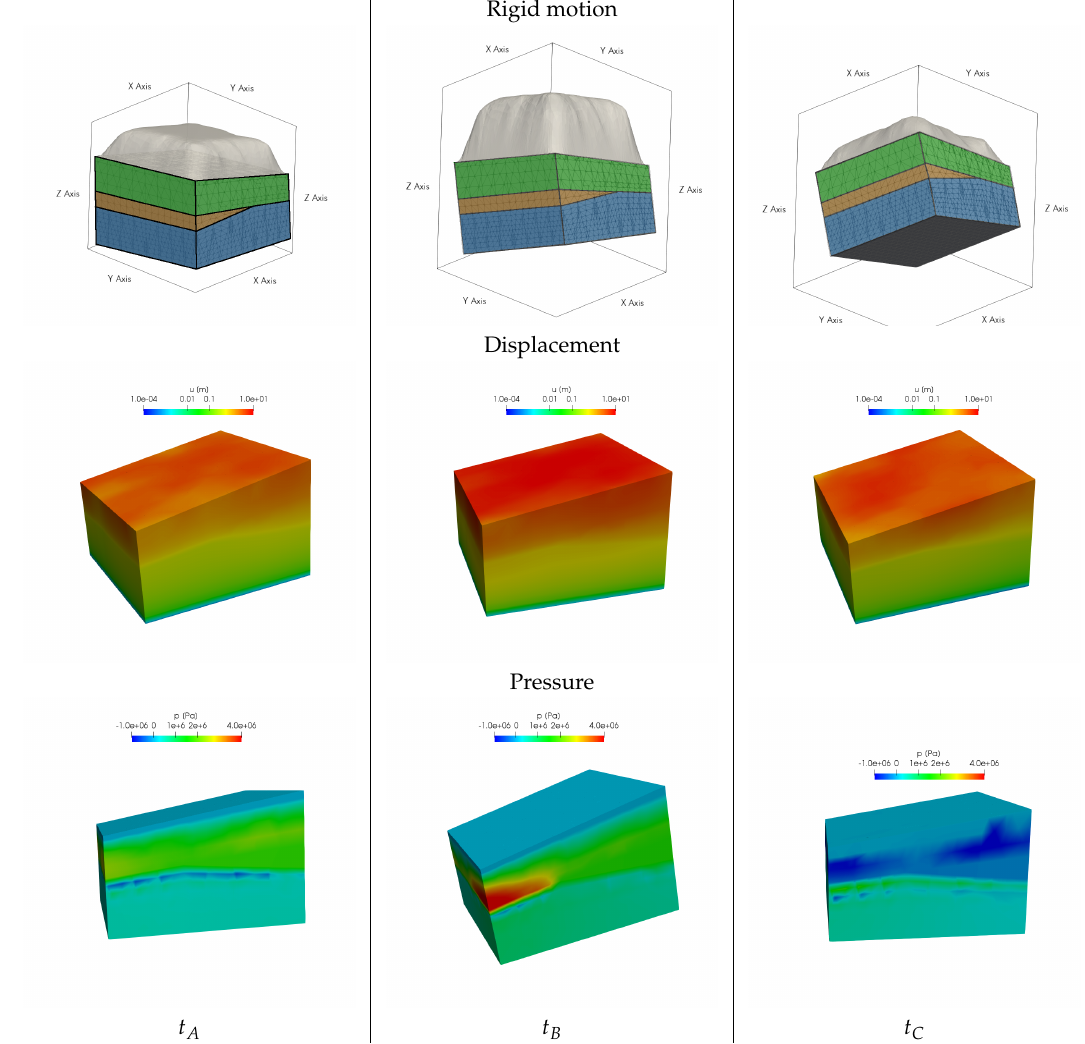
Figure 12. Evolution of the isostatic adjustment, the displacement and the pressure fields along the different phases of the simulation. In particular, we show on the top we show an the imposed rigid motion. The displacement (middle row) and the pressure fields (the variation from the hydrostatic pressure profile is shown, bottom row) are reported at times t A = 4.3 Ky , from left to right. −